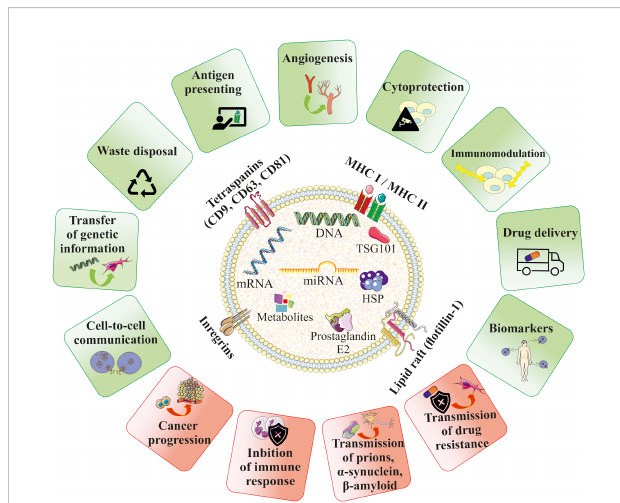
FIGURE 2 Biological role of EVs in homeostasis and pathophysiology. EVs contain bioactive cargo that is responsible for their multimodal activity. EVs may mimic the properties of their cells of origin and were shown to be paracrine factors that play role in cell-to-cell communication and in fl uence the fate of the target cells in several ways, including e.g. stimulation of angiogenesis, cell survival or modulation of the immune response. EVs may also serve as waste disposal machinery, drug-delivery systems and biomarkers for the diagnostic purposes. An in fl uence of EVs in the development of several diseases has been also